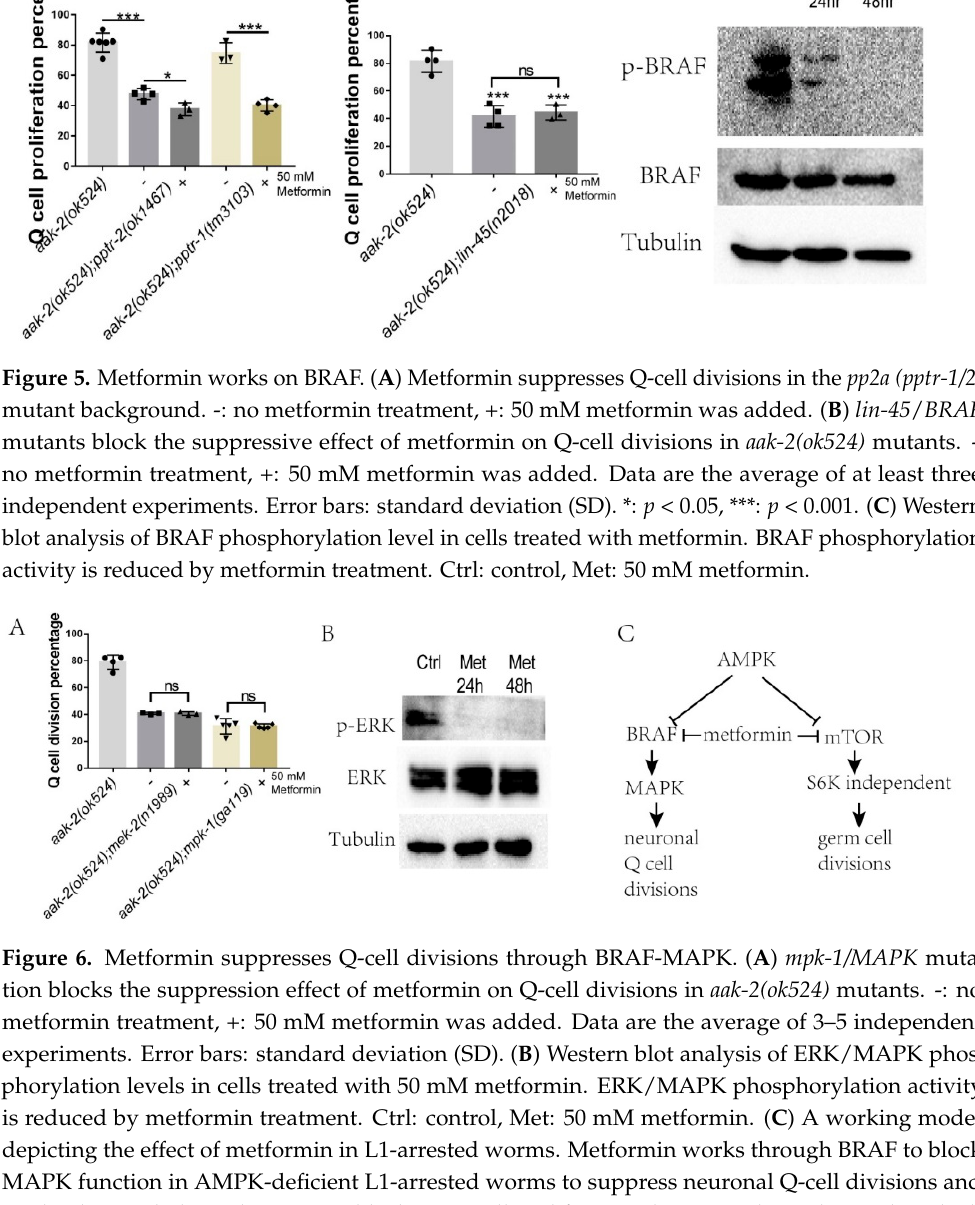
Figure 5. Metformin works on BRAF. ( A ) Metformin suppresses Q-cell divisions in the pp2a (pptr-1/2) mutant background. -: no metformin treatment, +: 50 mM metformin was added. ( B ) lin-45 / BRAF mutants block the suppressive effect of metformin on Q-cell divisions in aak-2(ok524) mutants. -: no metformin treatment, +: 50 mM metformin was added. Data are the average of at least three independent experiments. Error bars: standard deviation (SD). *: p < 0.05, ***: p < 0.001.